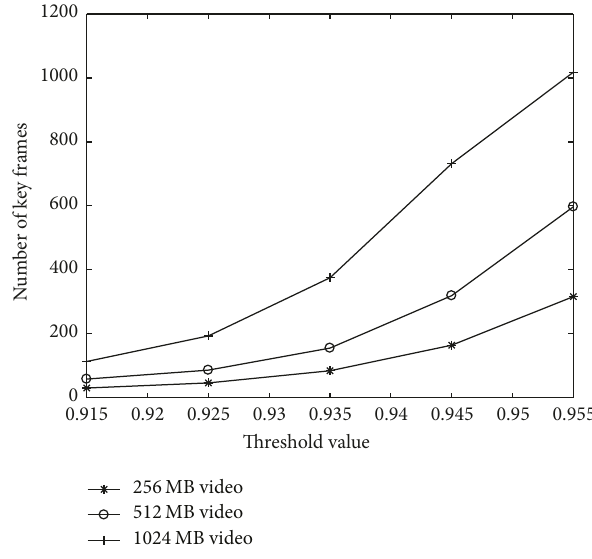
Figure 4: Threshold and number of key